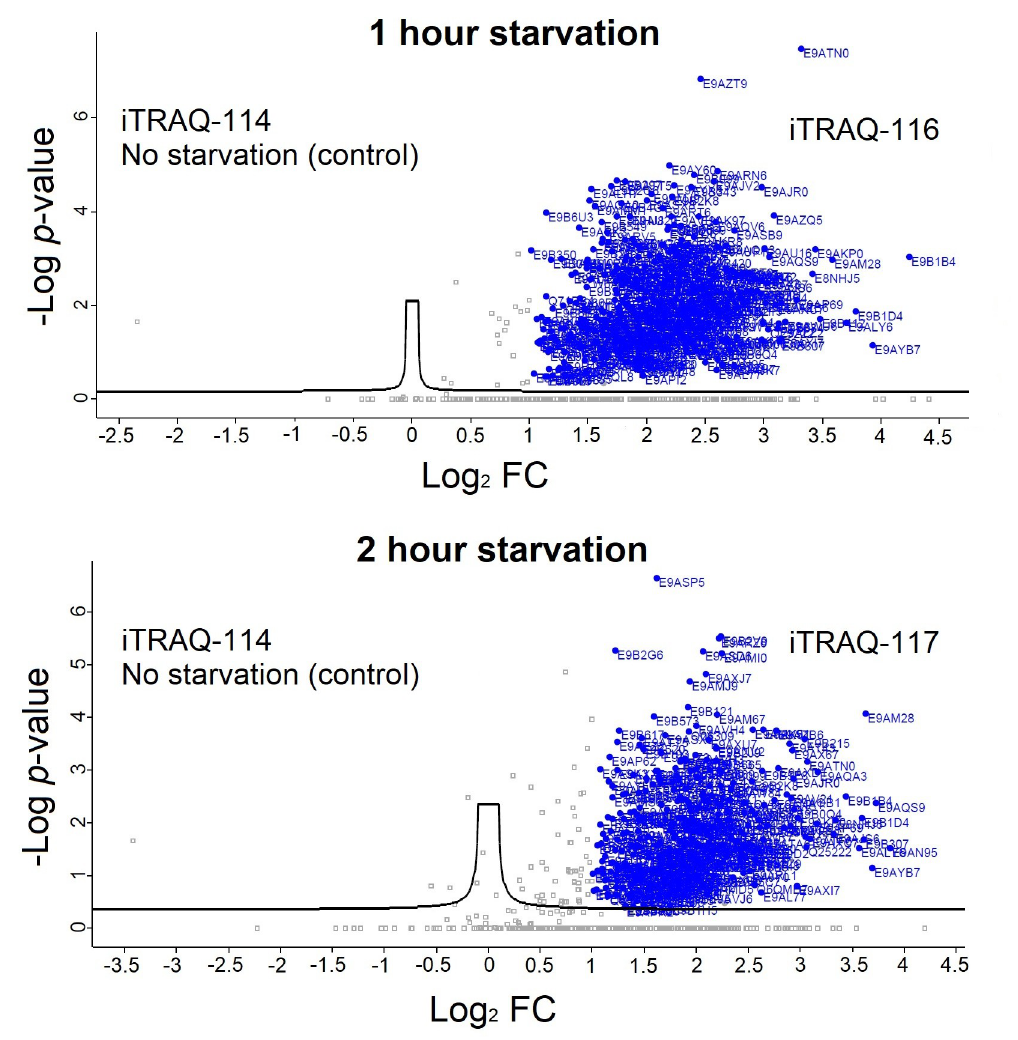
Fig 6. Starvation-responsive NSPs of L . mexicana promastigotes. Volcano plots of the starvation-responsive NSPs detected at 1 hour and 2 hour durations of starvation. The significance of the iTRAQ reporter intensities obtained for each NSP at 1 hour and 2 hours of starvation across two replicates as -Log P-values was plotted against the observed fold change (FC) in abundance in log 2 scale. Proteins with a log 2 FC of more than 1 with significant iTRAQ quantifications are highlighted in blue.